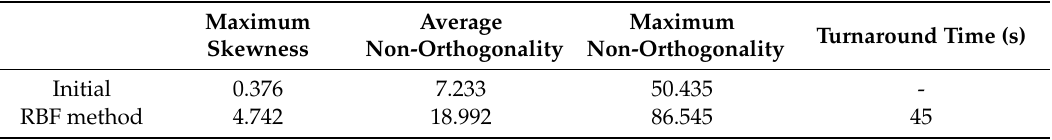
Figure 4. Deformed mesh using the radial basis function (RBF) method. ( a ) whole domain (side view), ( b ) near body (side view), ( c ) around leading edge (side view), ( d ) around trailing edge (side view). Table 1. Quality of deformed mesh by the RBF method.